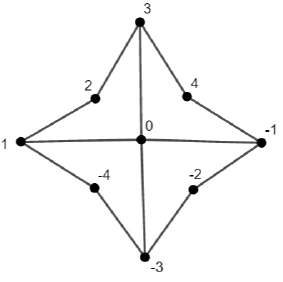
Figure 5: Integer cordial labeling of J